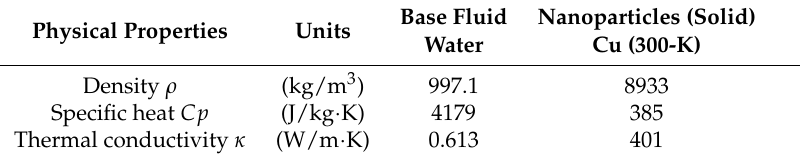
Table 1. Thermophysical properties of base fluid and nanoparticles